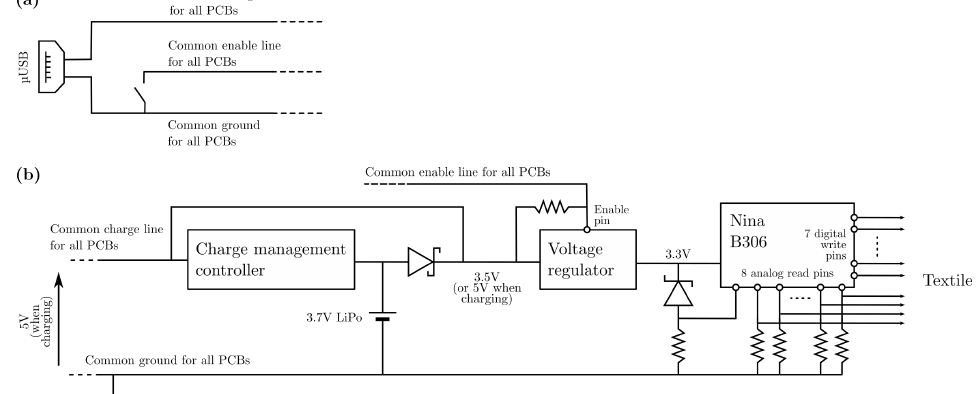
Figure 3. Conceptual schematic of the PCB. ( a ) Central control unit connecting multiple different smart textile PCBs. ( b ) Diagram for one smart textile